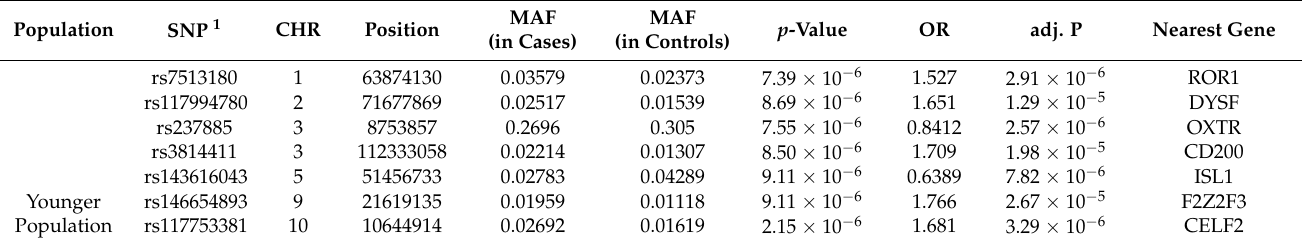
Figure 1. Manhattan plot showing the SNPs associated with cataracts identified from TWB2.0. Older cataract cases ( ≥ 60 years old, n = 5120) are shown in the top panel, while younger cataract cases (<60 years old, n = 1959) are shown in the bottom panel. Table 2. Selected cataract-associated SNPs identified by GWAS in TWB2.0 1.